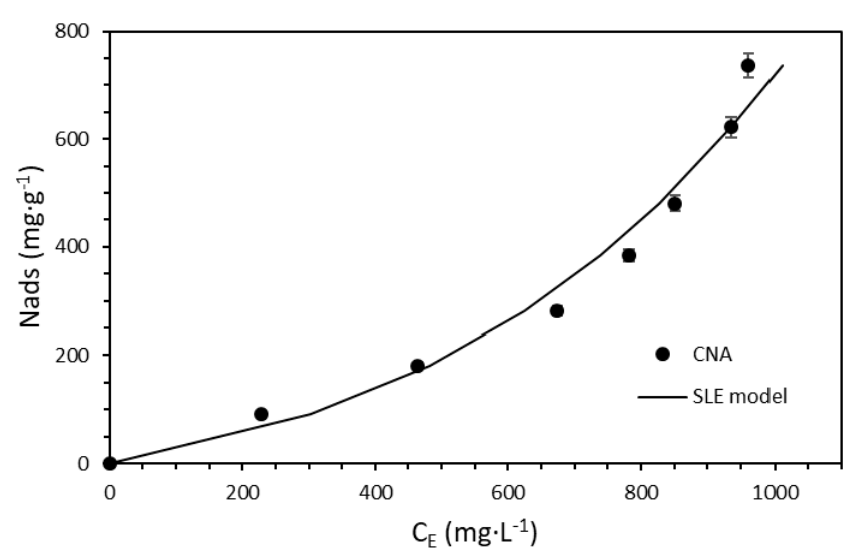
Figure 11. Adsorption isotherms constructed for a constant brine TDS of 0.75% with solutions prepared at 50 °C. The tests were performed using the thermogravimetric method with the SA/CNA system at a fixed concentration of the surfactant of 1000 mg·L − 1 and varying the nanoparticle concentrations to 50, 100, and 300 mg·L − 1 . The symbols represent the experimental data, while error bars represent standard deviation.